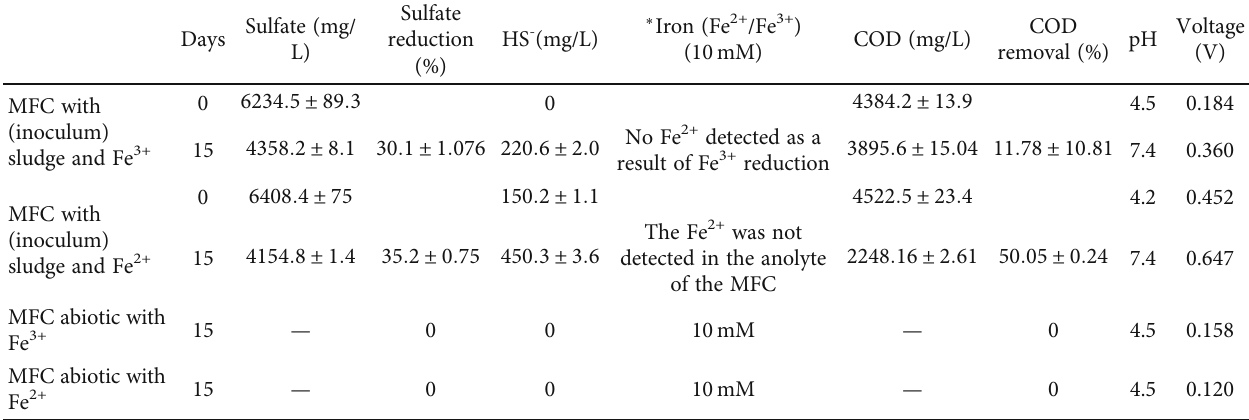
Table 3: Results obtained from the batch tests for each MFC with Fe 2+ and Fe 3+ inoculated with sludge and from the abiotic controls. Sulfate (mg/ Days L)